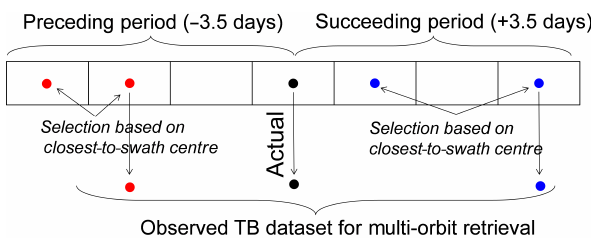
Figure 2. Selection of revisit orbits for the multi-orbit retrieval at SMOS